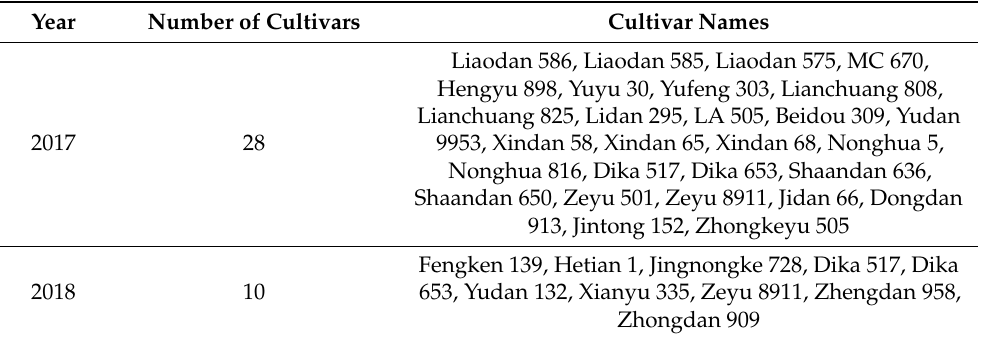
Figure 1. Temperature and precipitation during the growing seasons in 2017 and 2018. Table 1. Experimental maize cultivars planted in 2017 and